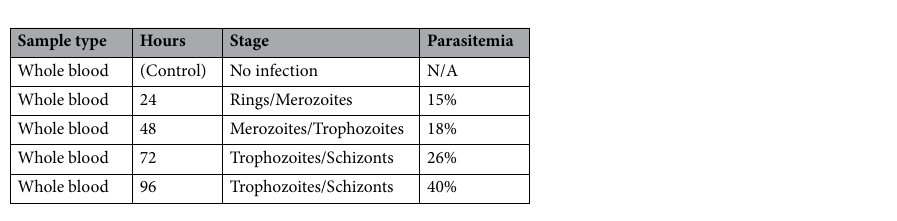
Table 3. Parasite density for blood culture samples.